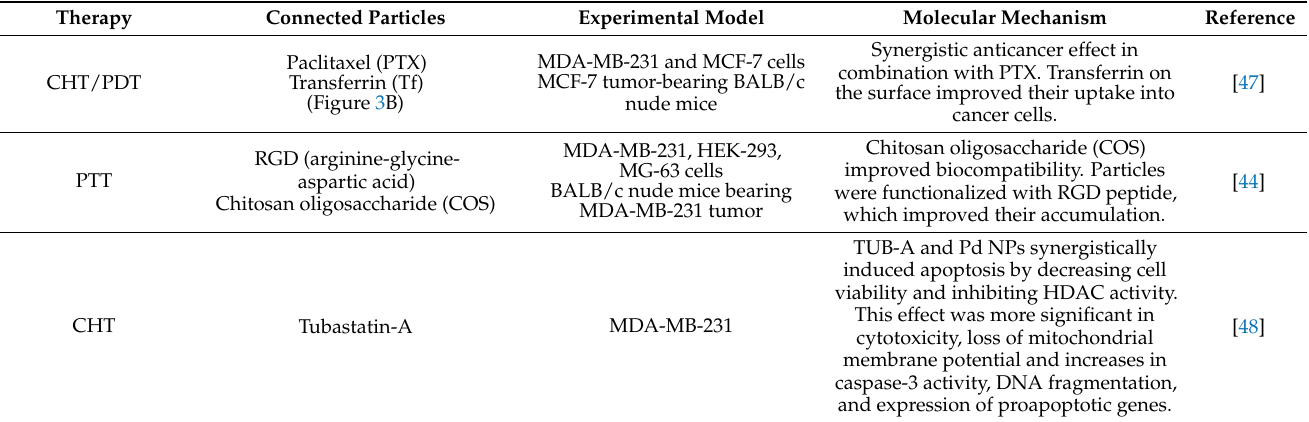
Table 4. Selected connections of biologically active molecules with palladium nanoparticles.